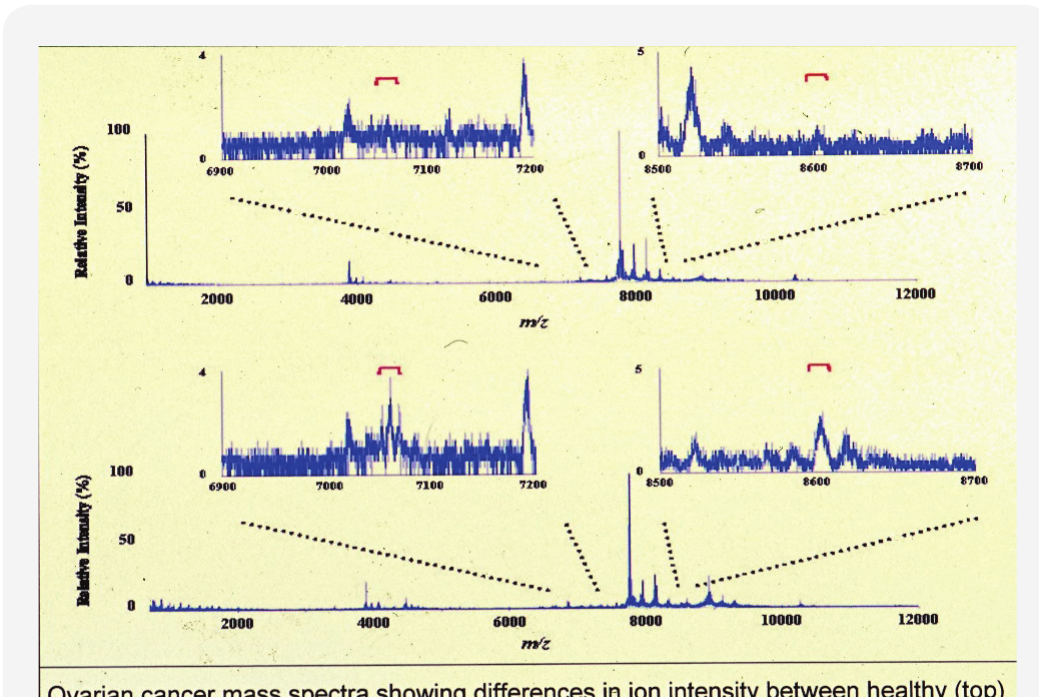
Figure 5. Mass spectrometer analysis of normal ovarian and ovarian cancer tissue. Source: Dr. Lance Liotta, George Mason